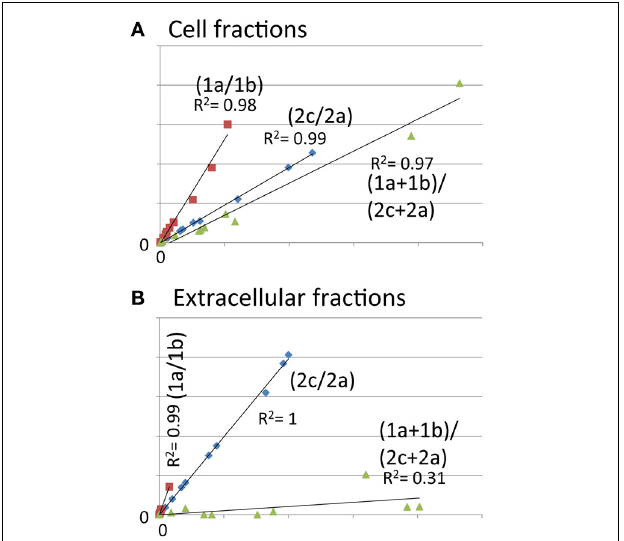
FIGURE 3 | Abundance of the N-terminal peptide of HrpA1 is very low in the extracellular fractions, indicating low abundance of full length HrpA1. Scatter plots of analyte peak counts of HrpA1 from twelve cell (A) and extracellular (B) samples (as in Figure 2 ). (A) Correlation of peak counts for transitions 1a and 1b from peptide ISATATNAK (red squares), 2c and 2a for peptide LTNLGNSAVGGVGGALQGVNTVASNATLQK (blue diamonds), and the sums of transitions from both peptides (green triangles). R squared values for trend lines are as indicated.